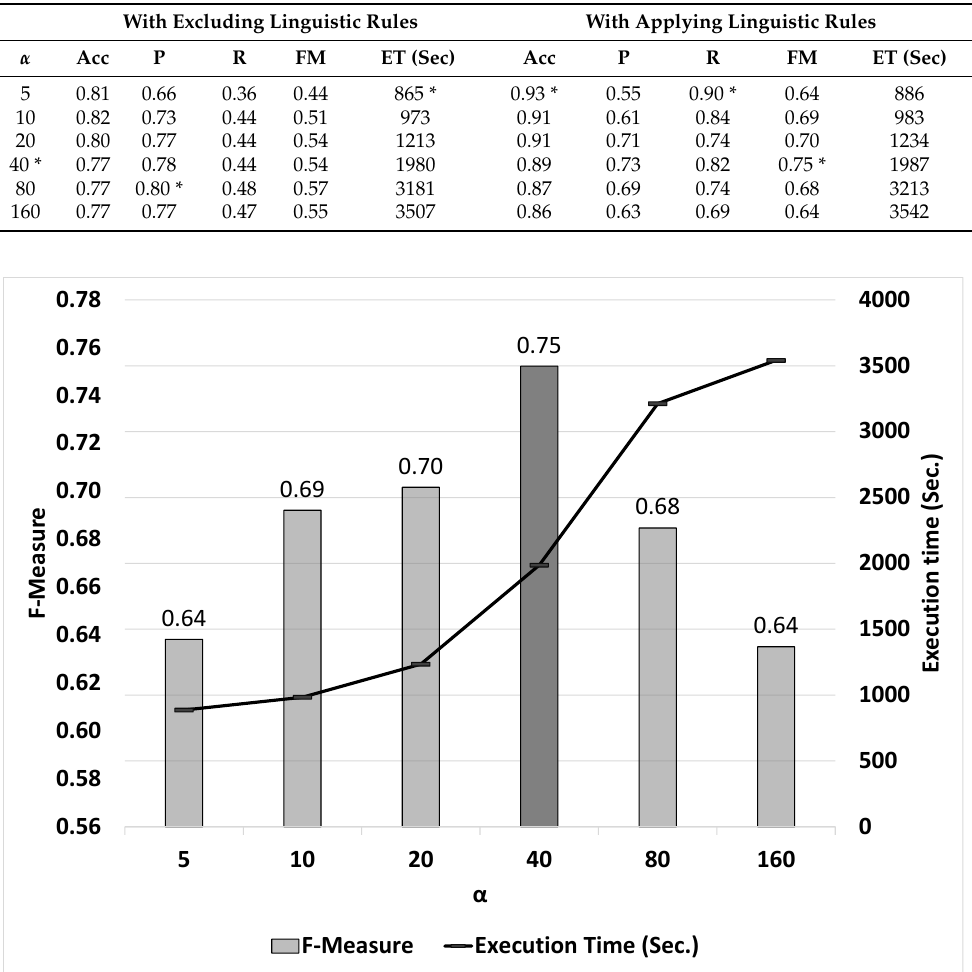
Figure 3. Impact of the parameters α (while θ = 0.4) on the effectiveness of PDTS w.r.t the trade-off between the f-measure score and execution